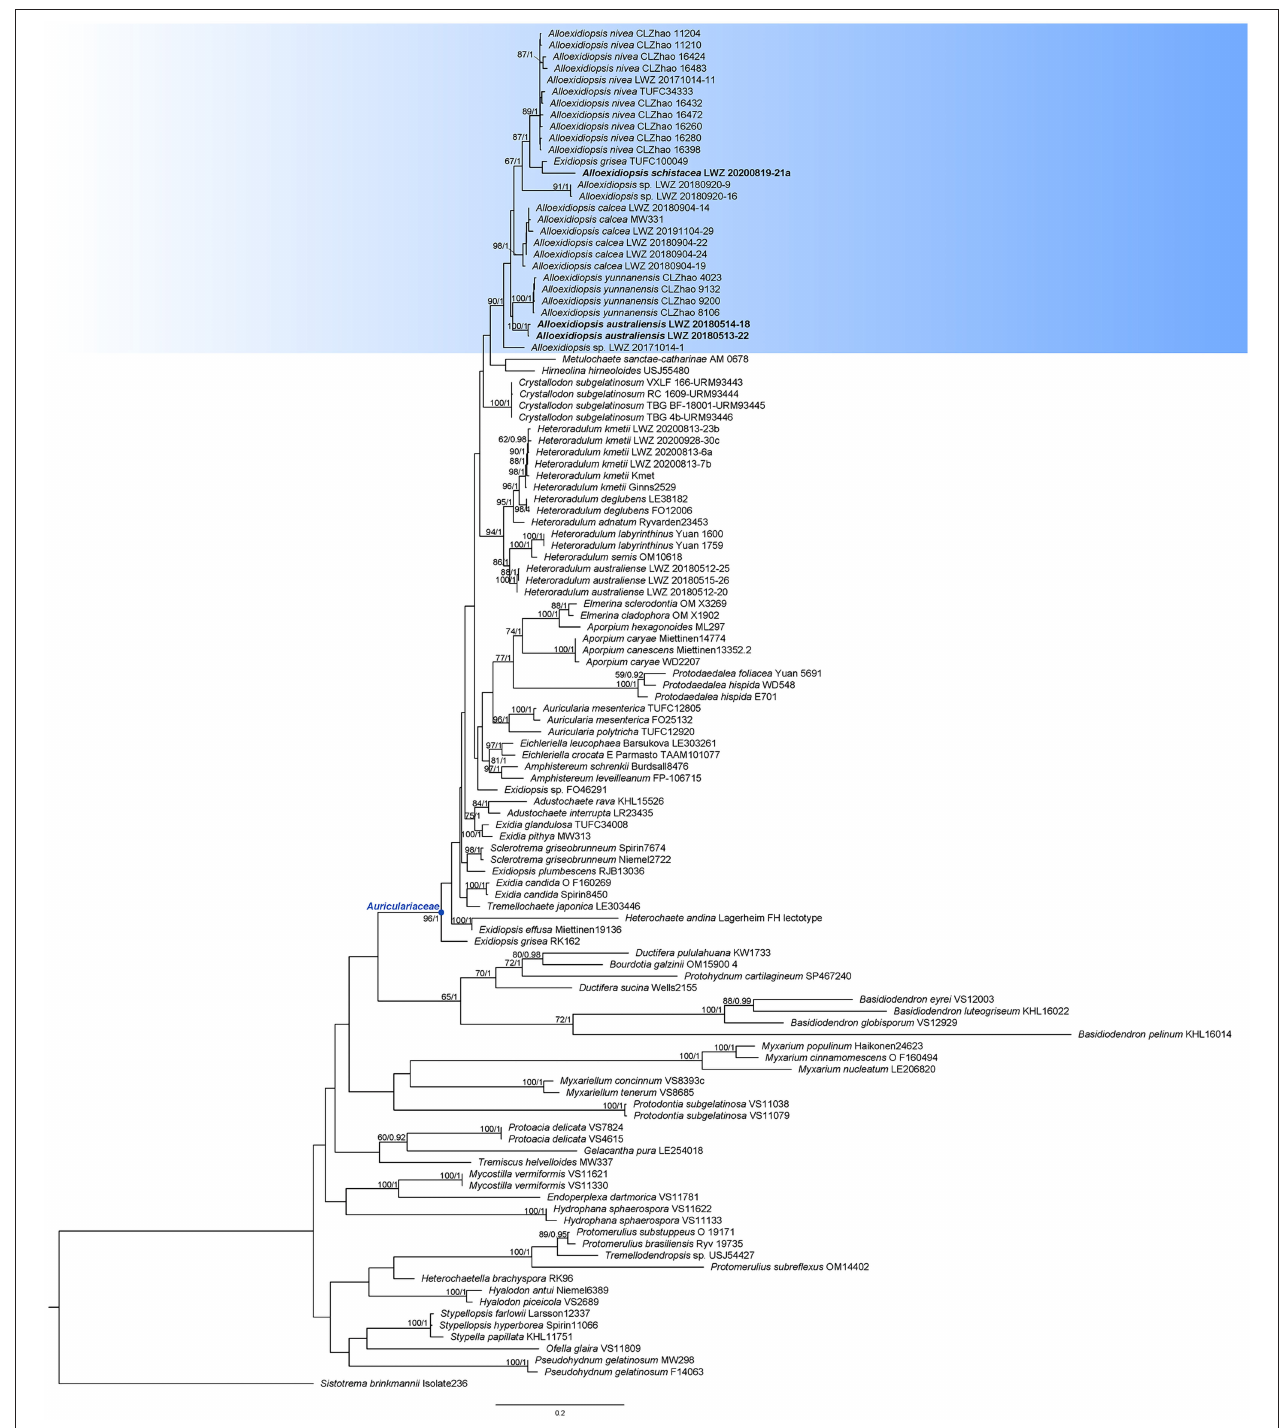
FIGURE 1 | Phylogenetic position of Alloexidiopsis in Auriculariales inferred from the concatenated dataset of internal transcribed spacer (ITS) and nuclear large subunit (nLSU) regions. The topology generated from the maximum likelihood analysis is shown along with bootstrap values and Bayesian posterior probabilities of more than 50% and 0.8, respectively, at the nodes. The new genus Alloexidiopsis is highlighted with the bluish background color, while the specimens of the newly described species are in boldface.